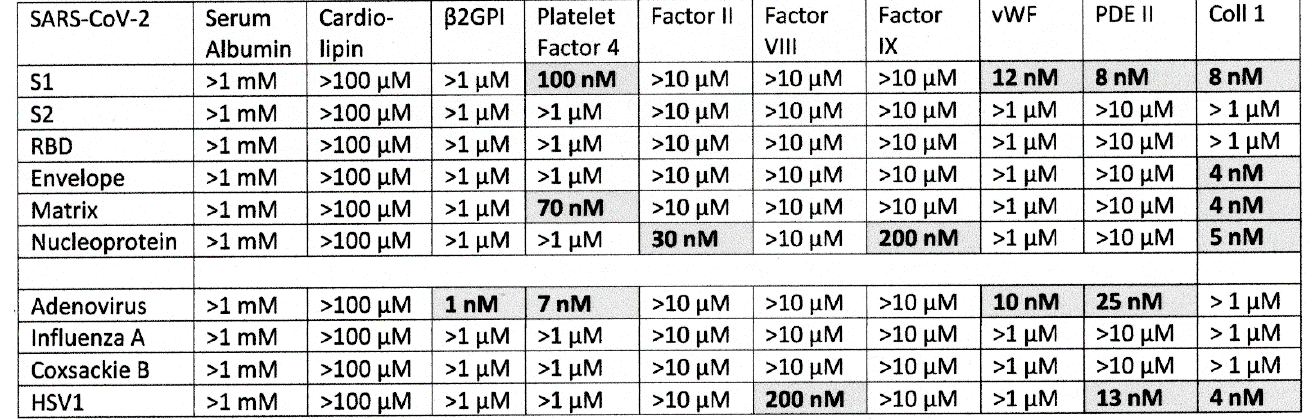
Figure 2. Summary of results of ELISA experiments exploring binding to blood proteins by SARS-CoV-2 polyclonal antibodies (rabbit) against the S1, S2, RBD, envelope, matrix and nucleoproteins, as well as experiments employing polyclonal antibodies against adenoviruses, influenza type A virus (H1N1), coxsackie B virus and human herpes simplex type 1 virus (HSV1). Binding constants were determined from the inflection point of the binding curves, some of which are illustrated in Figures 3–5. Significant binding is indicated by bolded numbers against a grey background. As noted in the Methods, S1 antibodies from different vendors were interchangeable, yielding identical results and are not distinguished here. For the definition of significance, see Section 2.2. β 2GPI = beta 2 glycoprotein I; vWF = von Willebrand Factor; PDE = phosphodiesterase II; Coll 1 = collagen.